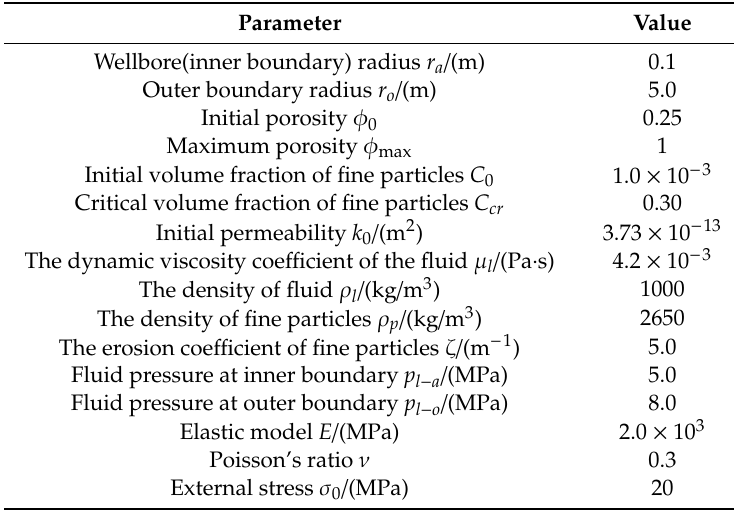
Table 1. Physical parameters for numerical calculation.